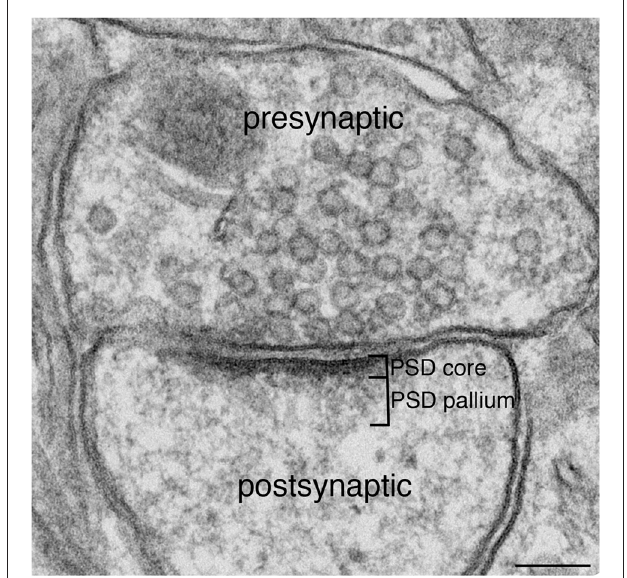
FIGURE 1 | Excitatory synapse. Excitatory glutamatergic synapses typically display a prominent electron-dense zone juxtaposed to the postsynaptic membrane, traditionally known as the postsynaptic density (PSD). Extending deeper from the PSD core is a specialized region we call the PSD pallium. Scale bar: 0.1 µ